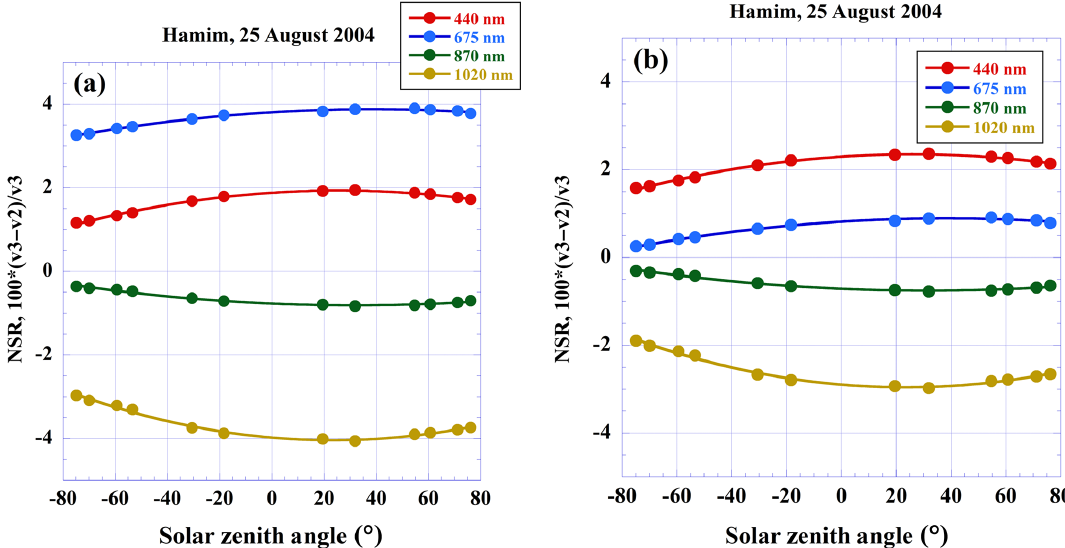
Figure 6. Effect of solar flux and temperature correction on relative percent difference in normalized sky radiances for Hamim: (a) joint effect of temperature correction and solar flux; (b) the effect of solar flux is